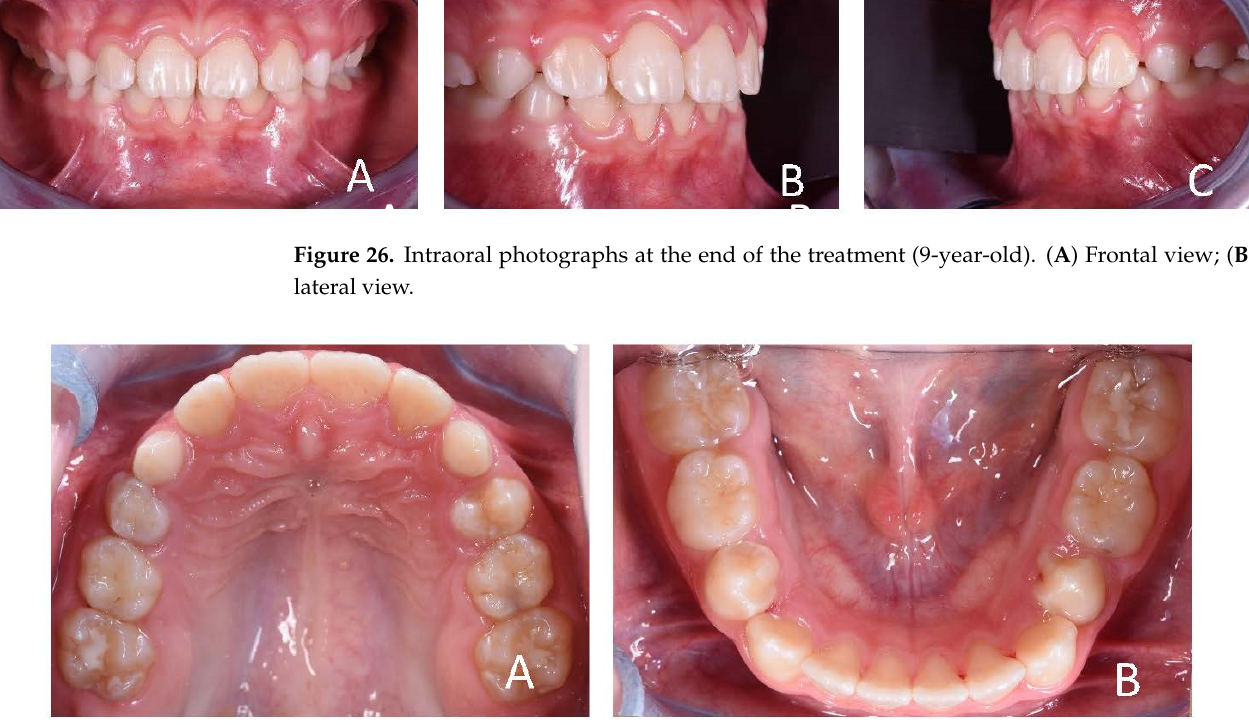
Figure 27. Final occlusal photos of dental arches (9-year-old). ( A ) Upper arch; ( B ) lower arch.